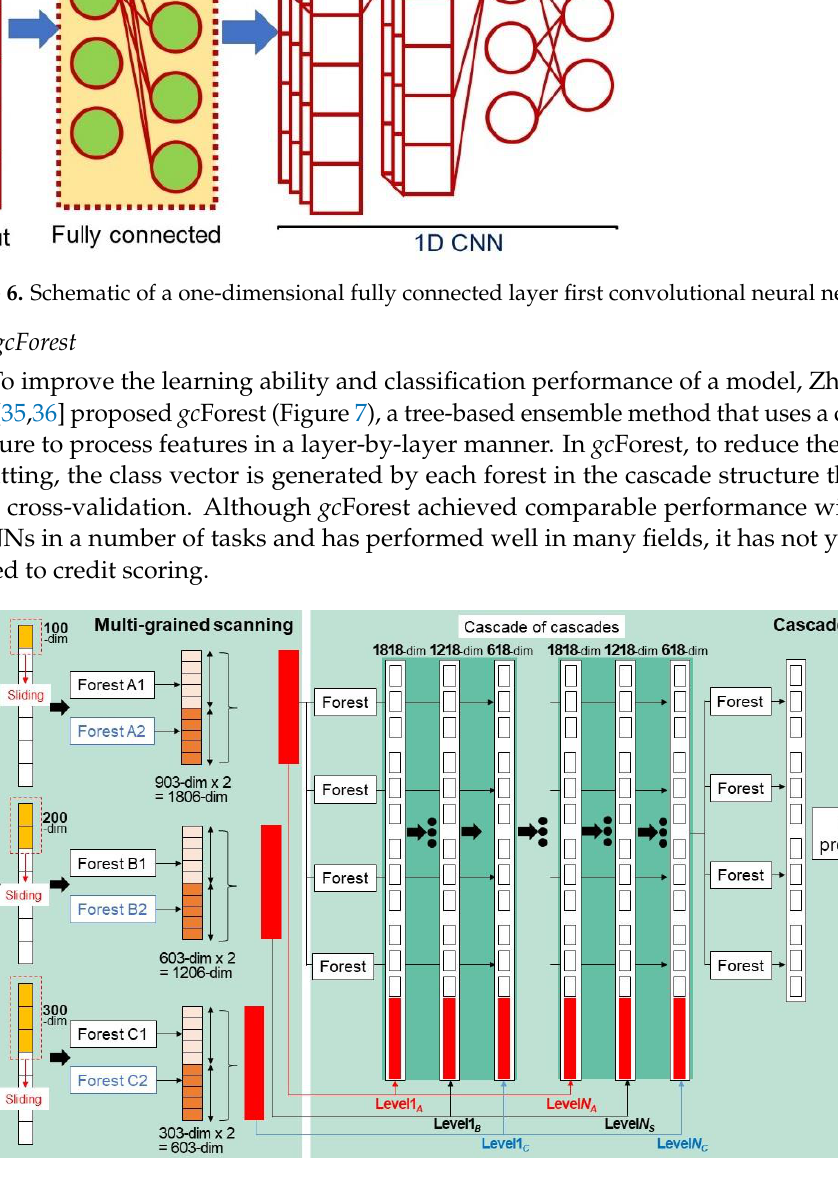
Figure 7. Schematic overview of the main part of gc Forest. Source: Zhou and Feng [35,36].